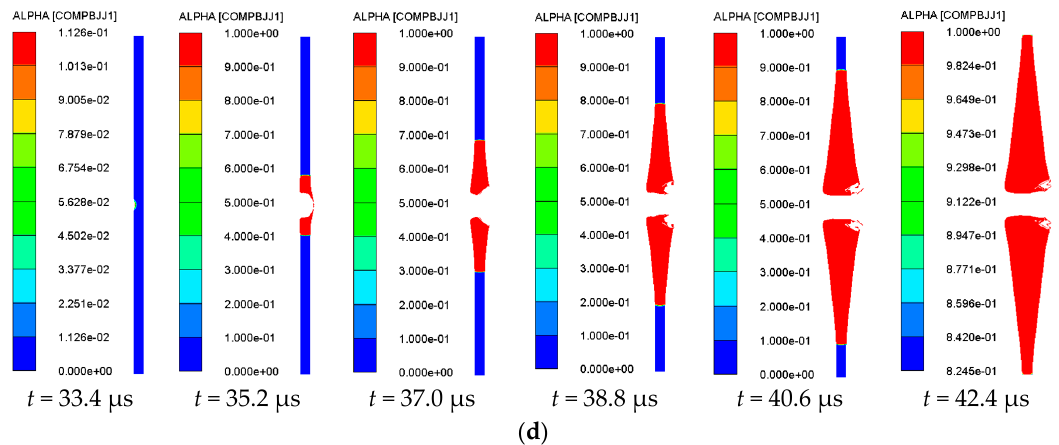
Figure 7. The reaction degree contour of the sandwiched charge corresponding to different jet types: ( a ) copper; ( b ) floatglass; ( c ) Lucite; and ( d ) Plexiglas.